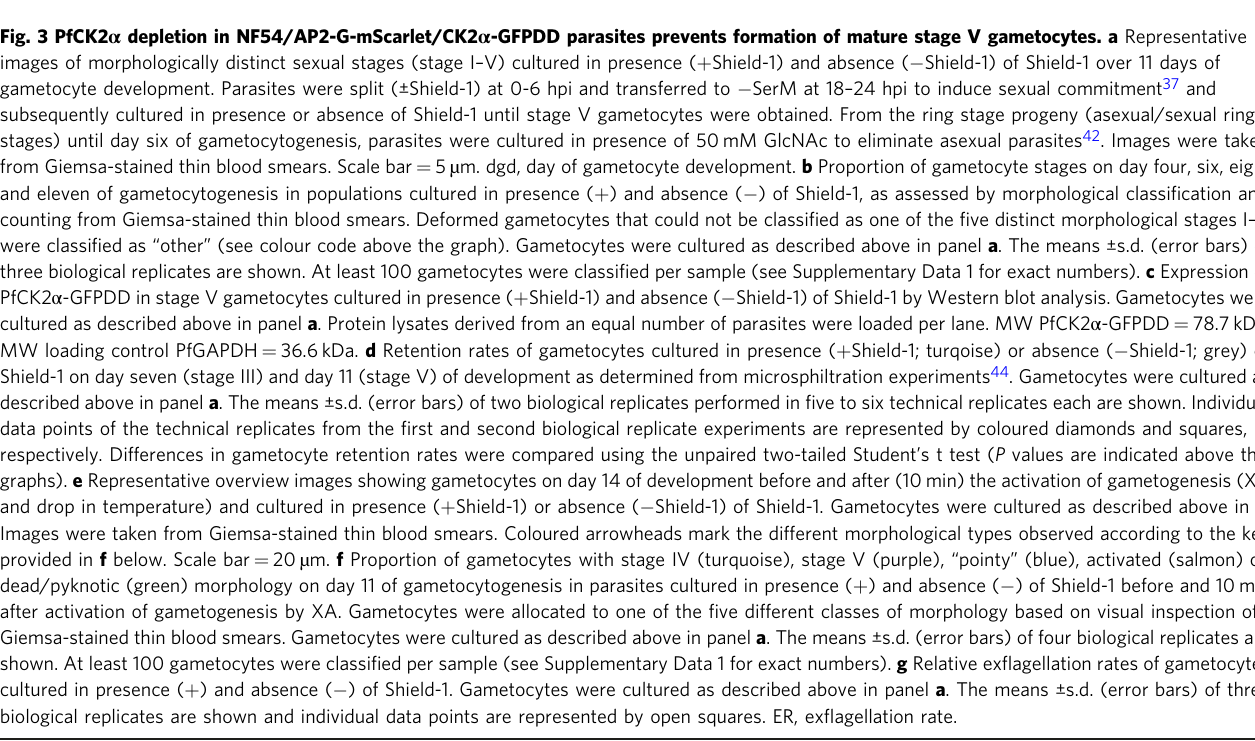
Fig. 3 PfCK2 α depletion in NF54/AP2-G-mScarlet/CK2 α -GFPDD parasites prevents formation of mature stage V gametocytes. a Representative images of morphologically distinct sexual stages (stage I – V) cultured in presence ( + Shield-1) and absence ( − Shield-1) of Shield-1 over 11 days of gametocyte development. Parasites were split (±Shield-1) at 0-6 hpi and transferred to − SerM at 18 – 24 hpi to induce sexual commitment 37 and subsequently cultured in presence or absence of Shield-1 until stage V gametocytes were obtained. From the ring stage progeny (asexual/sexual ring stages) until day six of gametocytogenesis, parasites were cultured in presence of 50 mM GlcNAc to eliminate asexual parasites 42 . Images were taken from Giemsa-stained thin blood smears. Scale bar = 5 µ m. dgd, day of gametocyte development. b Proportion of gametocyte stages on day four, six, eight and eleven of gametocytogenesis in populations cultured in presence ( + ) and absence ( − ) of Shield-1, as assessed by morphological classi fi cation and counting from Giemsa-stained thin blood smears. Deformed gametocytes that could not be classi fi ed as one of the fi ve distinct morphological stages I – V were classi fi ed as “ other ” (see colour code above the graph). Gametocytes were cultured as described above in panel a . The means ±s.d. (error bars) of three biological replicates are shown. At least 100 gametocytes were classi fi ed per sample (see Supplementary Data 1 for exact numbers). c Expression of PfCK2 α -GFPDD in stage V gametocytes cultured in presence ( + Shield-1) and absence ( − Shield-1) of Shield-1 by Western blot analysis. Gametocytes were cultured as described above in panel a . Protein lysates derived from an equal number of parasites were loaded per lane. MW PfCK2 α -GFPDD = 78.7 kDa, MW loading control PfGAPDH = 36.6 kDa. d Retention rates of gametocytes cultured in presence ( + Shield-1; turqoise) or absence ( − Shield-1; grey) of Shield-1 on day seven (stage III) and day 11 (stage V) of development as determined from microsphiltration experiments 44 . Gametocytes were cultured as described above in panel a . The means ±s.d. (error bars) of two biological replicates performed in fi ve to six technical replicates each are shown. Individual data points of the technical replicates from the fi rst and second biological replicate experiments are represented by coloured diamonds and squares, respectively. Differences in gametocyte retention rates were compared using the unpaired two-tailed Student ’ s t test ( P values are indicated above the graphs). e Representative overview images showing gametocytes on day 14 of development before and after (10 min) the activation of gametogenesis (XA and drop in temperature) and cultured in presence ( + Shield-1) or absence ( − Shield-1) of Shield-1. Gametocytes were cultured as described above in a . Images were taken from Giemsa-stained thin blood smears. Coloured arrowheads mark the different morphological types observed according to the key provided in f below. Scale bar = 20 µ m. f Proportion of gametocytes with stage IV (turquoise), stage V (purple), “ pointy ” (blue), activated (salmon) or dead/pyknotic (green) morphology on day 11 of gametocytogenesis in parasites cultured in presence ( + ) and absence ( − ) of Shield-1 before and 10 min after activation of gametogenesis by XA. Gametocytes were allocated to one of the fi ve different classes of morphology based on visual inspection of Giemsa-stained thin blood smears. Gametocytes were cultured as described above in panel a . The means ±s.d. (error bars) of four biological replicates are shown. At least 100 gametocytes were classi fi ed per sample (see Supplementary Data 1 for exact numbers). g Relative ex fl agellation rates of gametocytes cultured in presence ( + ) and absence ( − ) of Shield-1. Gametocytes were cultured as described above in panel a . The means ±s.d. (error bars) of three biological replicates are shown and individual data points are represented by open squares. ER, ex fl agellation